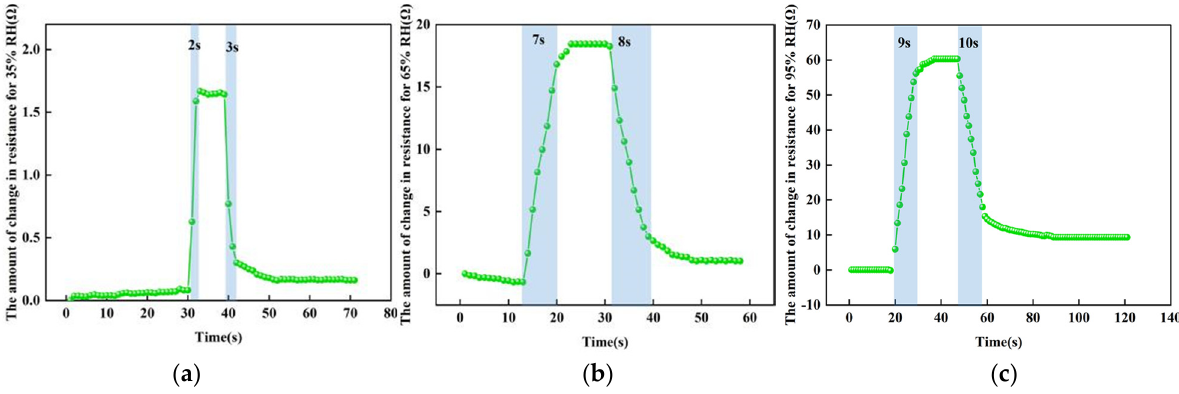
Figure 14. The test results at different humidity levels. ( a ) At 35% RH. ( b ) At 65% RH. ( c ) At 95% RH.